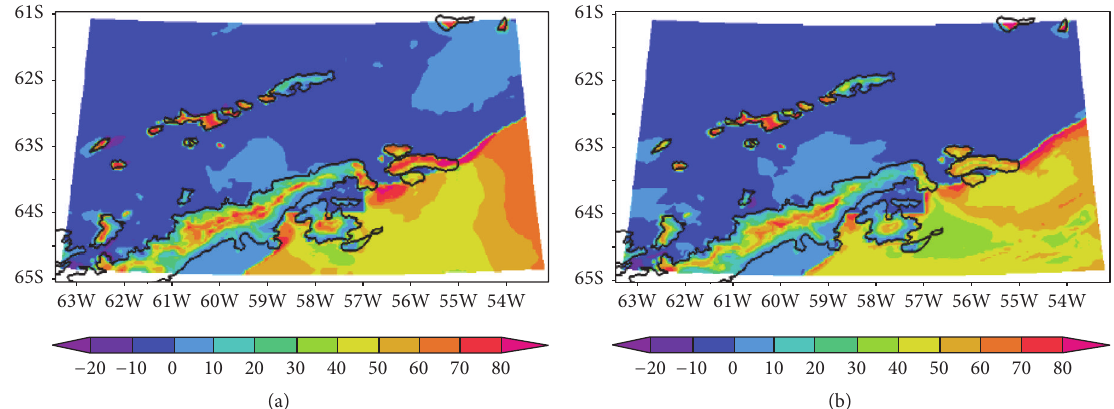
Figure 11: Sensible heat flux (W/m 2 ) simulated with WRF: (a) 29 December 2014 at 19:00 UTC and (b) 30 December 2014 at 18:00